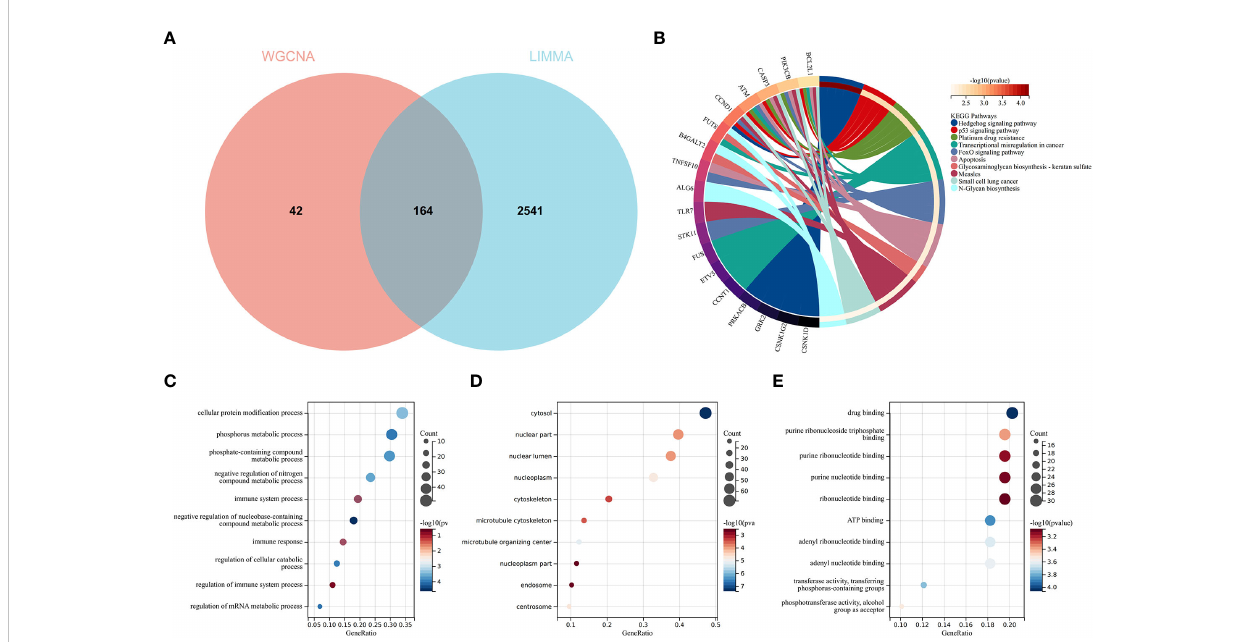
FIGURE 4 Function enrichment analysis of the intersection of genes for RA. (A) The intersection of DEGs via Limma and WGCNA module genes includes 164 genes, which were shown in the Venn diagram. (B) KEGG analysis of the intersection of genes. Various signi fi cant pathways and associated genes are represented with different colors. (C – E) The GO analysis includes biological process, cellular component, and molecular function. The y -axis represents GO terms, and the x -axis represents gene ratio involved in corresponding GO terms. The size of circles represents gene numbers, and their color refers to p